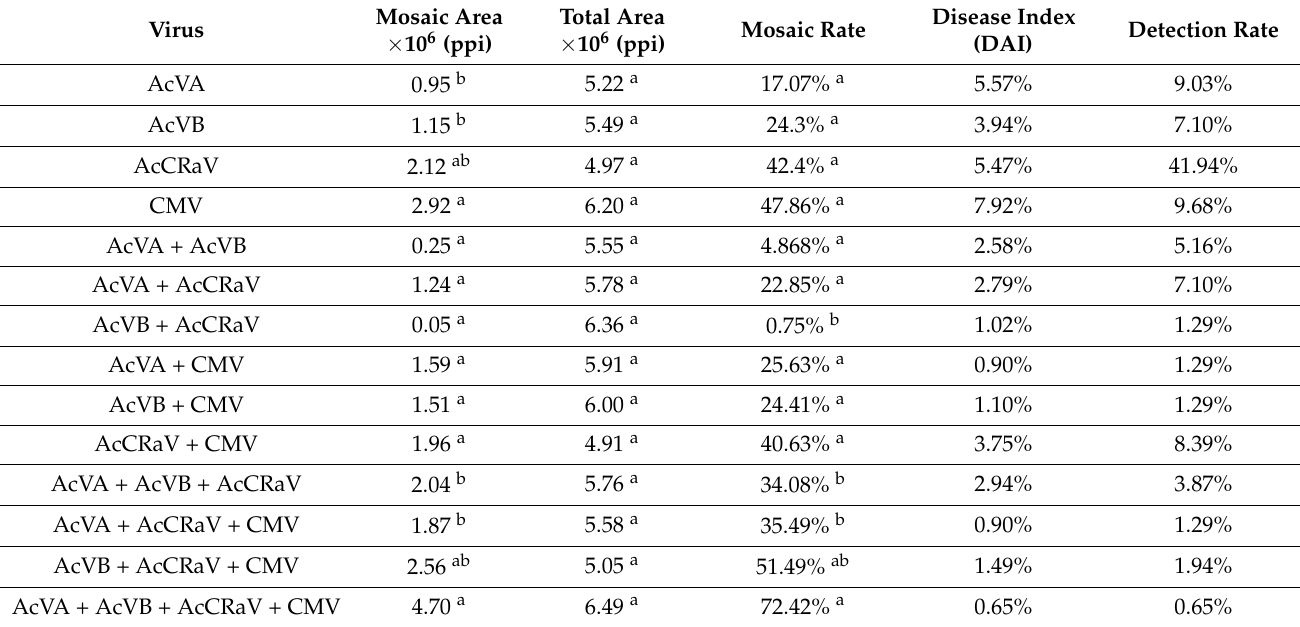
Table 1. The mean mosaic rate and disease index of viruses in the Sichuan province, China. Values with different letters in a column differ significantly ( p <